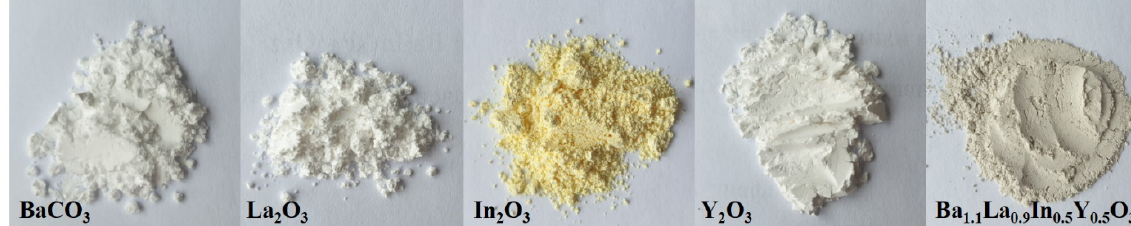
Figure 2. The pictures of powders of initial materials and obtained composition.